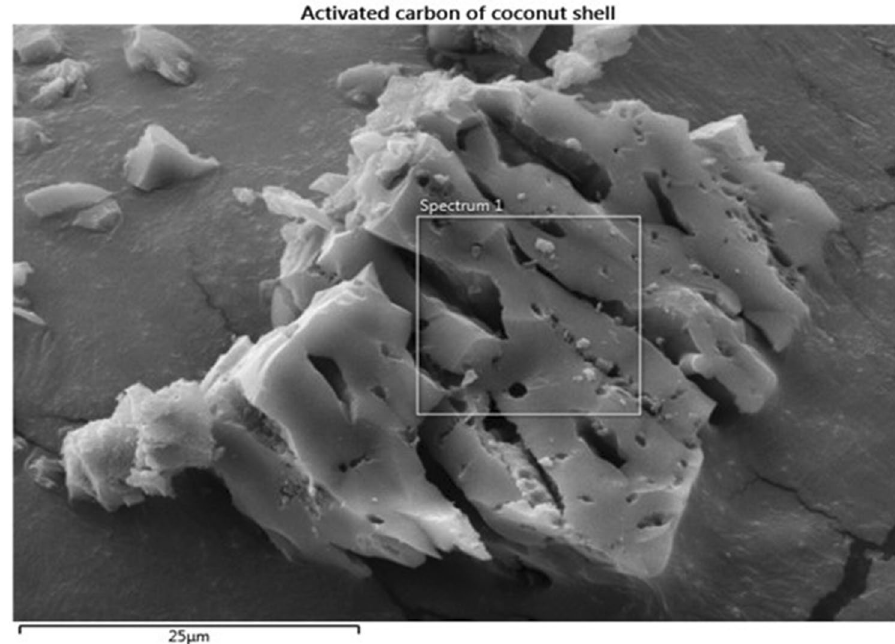
Fig. 1 Scanning electron micro- scopic analysis of activated carbon made from coconut